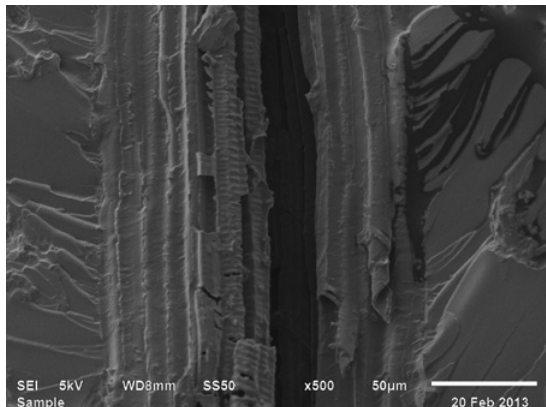
Figure 2 SEM micrograph for (CY-230+8 wt% HY-951+0.5 wt%